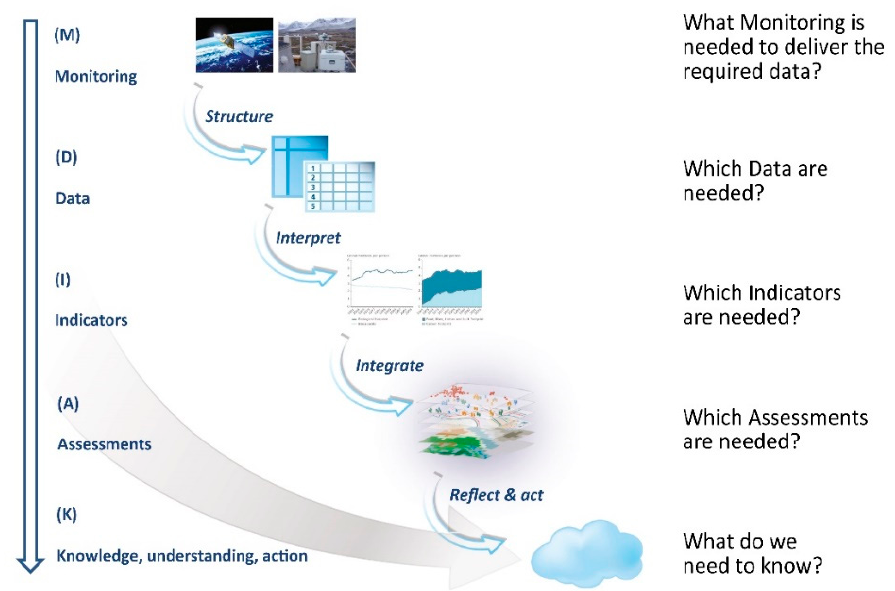
Figure 1. The Monitoring–Data–Indicator–Assess–Knowledge (MDIAK) reporting chain leading to knowledge, understanding, and action (on the right-hand side the same chain can be used to design assessments, communicate results and support the monitoring).